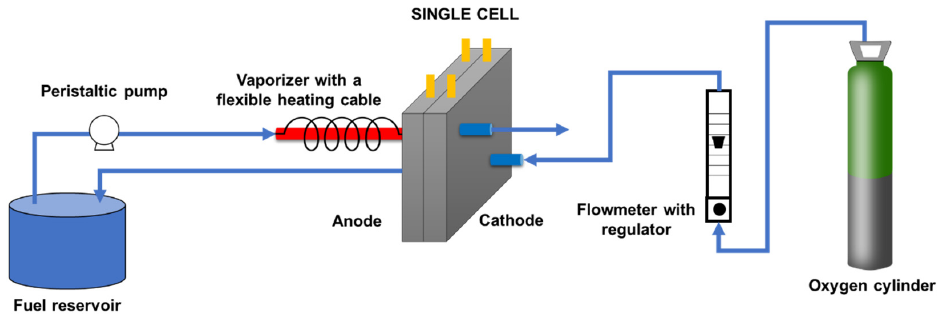
Figure 6. Scheme of the experimental setup for the single-cell studies of the prepared MEA.